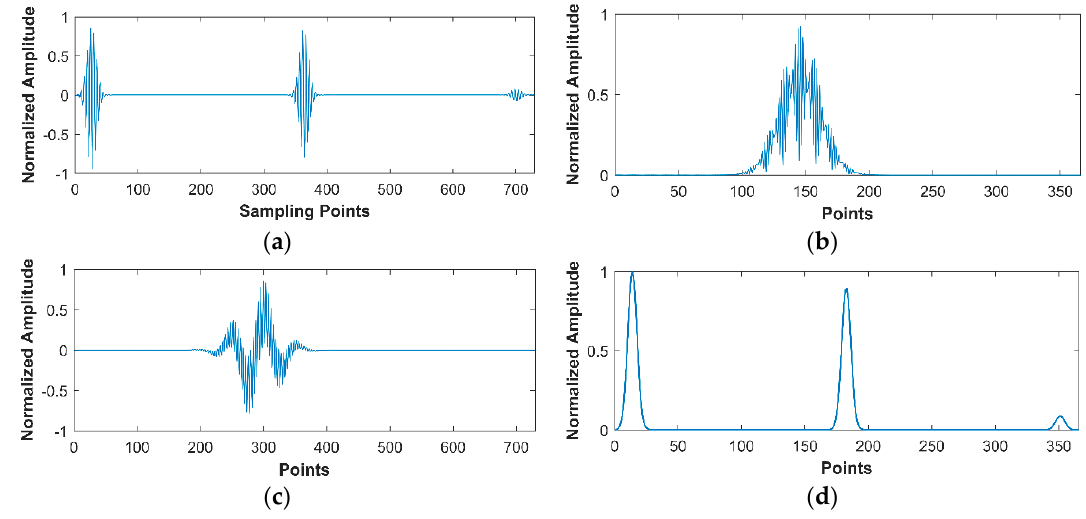
Figure 9. ( a ) Extracted A-scan signal from 25 MHz SR image; ( b ) the Discrete Fourier Transform (DFT) spectrum of ( a ); ( c ) the Discrete Cosine Transform (DCT) coefficients of ( a ); ( d ) the DFT spectrum of ( c ).